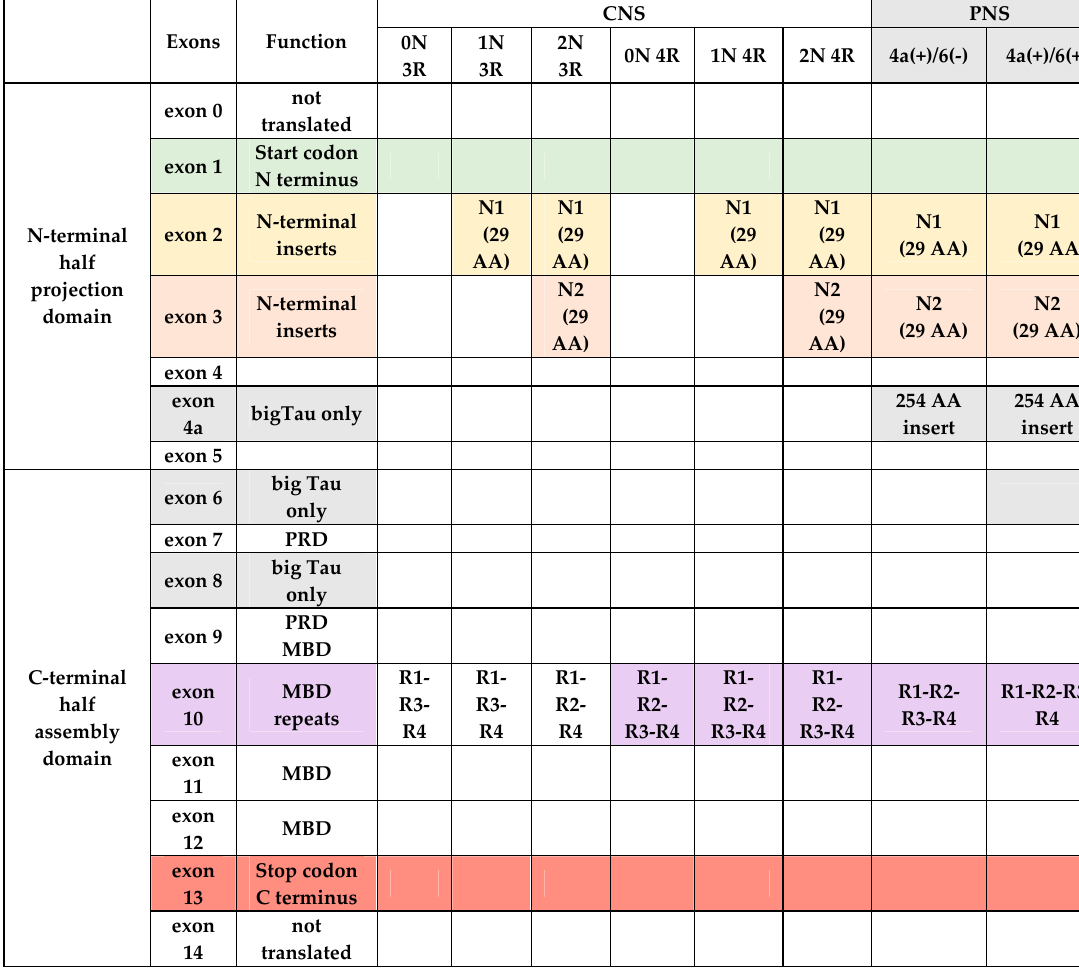
Figure 2. Schematic structure of Tau molecule in central (CNS) and peripheral nervous system (PNS) in relation to alternative splicing of exons. Abbreviations; PRD — proline rich domain, MBD — microtubule binding domain, AA — aminoacids.